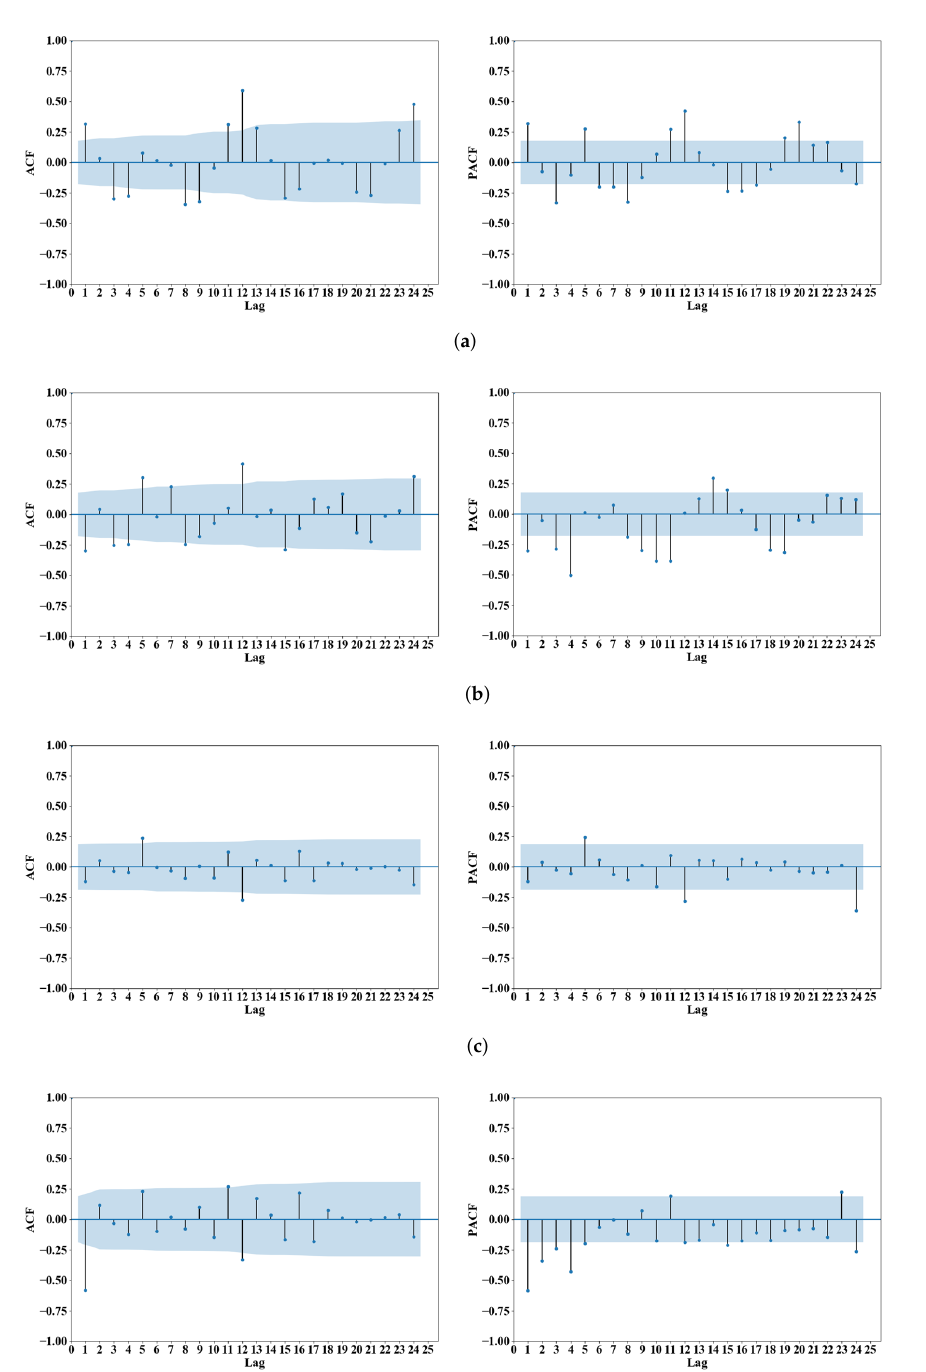
Figure 3. ACF and PACF plots of EDH time series with different differencing combinations: ( a ) ithout differencing, ( b ) with non-seasonal differencing, ( c ) with seasonal differencing and ( d ) with non- seasonal and seasonal differencing